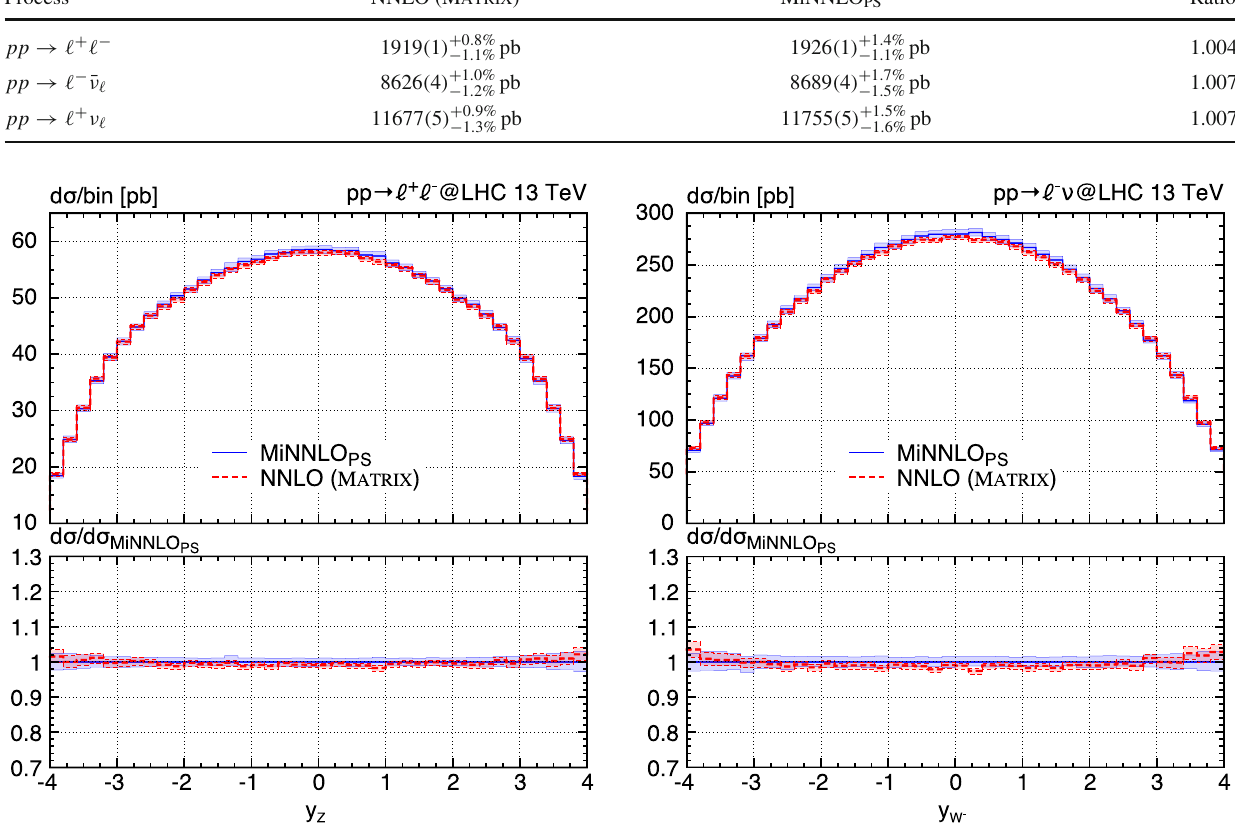
Fig. 3 The rapidity distribution of the leptonic pair in neutral- (left plot) and charged-current (right plot) Drell Yan production. The lower panel shows the ratio of the NNLO and the MiNNLO PS predictions to the